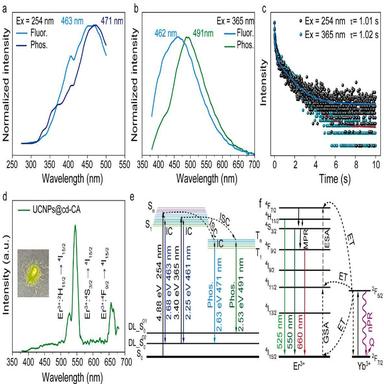
a, b) Fluorescence and phosphorescence emission spectra of UCNPs@cd-CA under excitation of a) 254 nm and b) 365 nm, c) phosphorescence decay kinetics at emission peak of 471 nm and 491 nm, respectively, d) upconversion emission spectra of UCNPs@cd-CA under 980-nm laser excitation (the inset shows the corresponding fluorescence diagram), e, f) the energy level diagram of the two components of UCNPs@cd-CA (e: cd-CA and f: UCNPs). Noted that MPR represents multiphoton relaxation, nPR represents non-radiative r